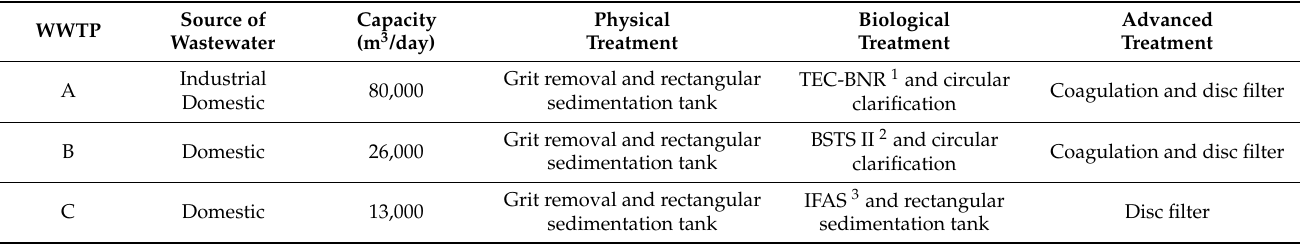
Table 1. Characteristics of WWTPs.